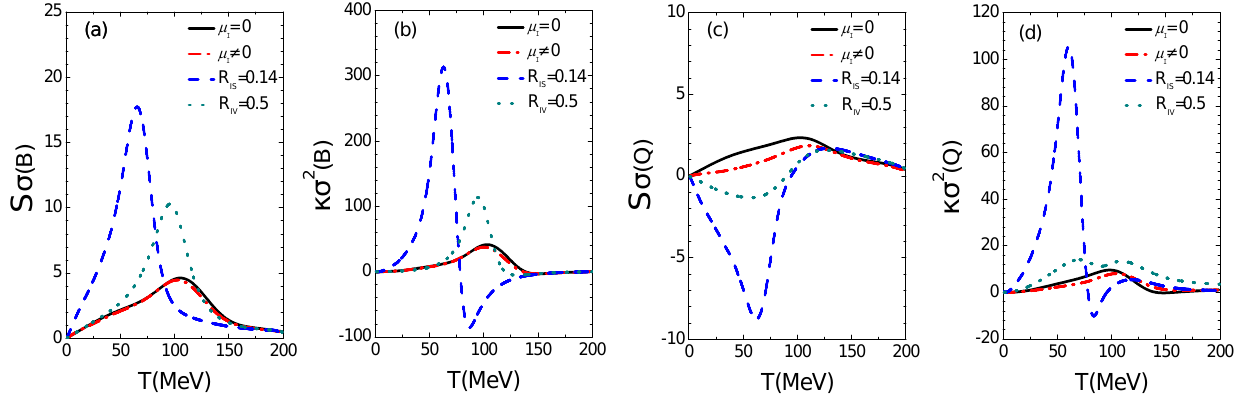
Figure 3. (color online) S σ and κσ 2 for net-baryon (B) ( a , b ) and net-charge (Q) ( c , d ) fluctuations along the closest hypothetical chemical freeze-out line to the phase boundary with four representative scenarios of isospin chemical potentials and isovector